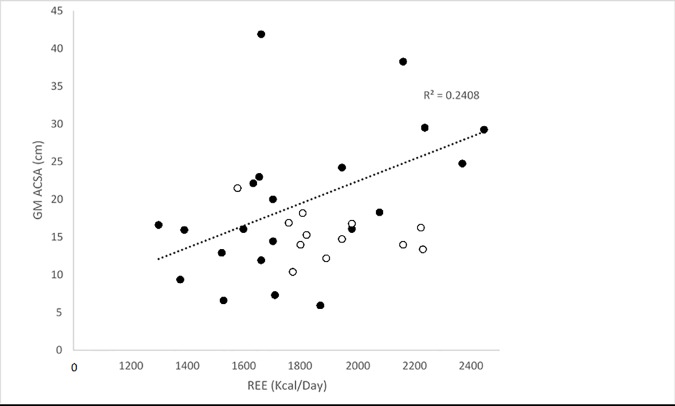
Relationship between GM ACSA and REE in BeMD (closed circles) and Control (open circles) participants.GM = Gastrocnemius Medialis; ACSA = Anatomical Cross Sectional Area; cm = centimetres; REE = Resting Energy Expenditure; Kcal = Kilocalories.